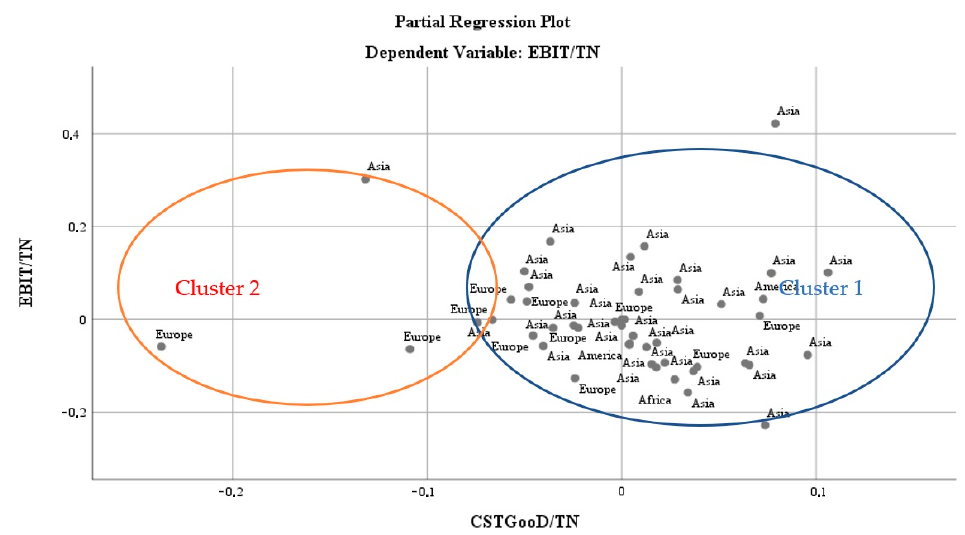
Figure 3. Distribution clusters of the value of the productive efficiency regressor in relation to the overall economic performance rate.